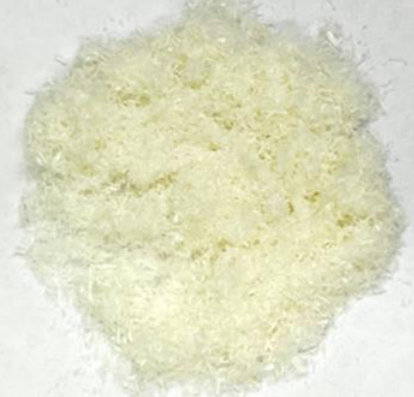
Figure 1. Cellulosic product obtained by peroxide delignification of spruce wood in the